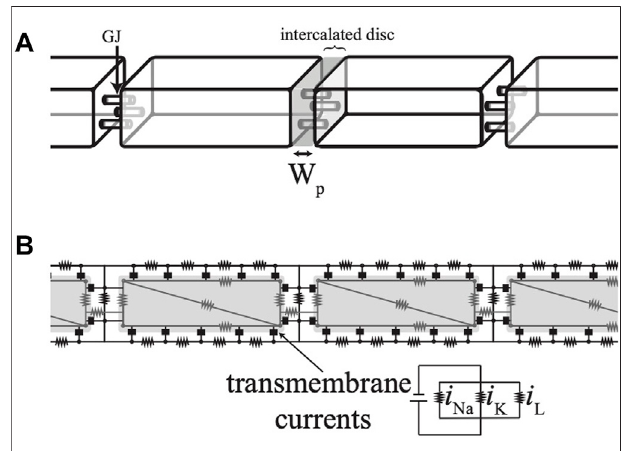
FIGURE 1 | (A) Simulations were conducted on a strand of cells modeled as rectangular prisms. (B) A top-down cross-section of the cells shows the numerical scheme as an electrical